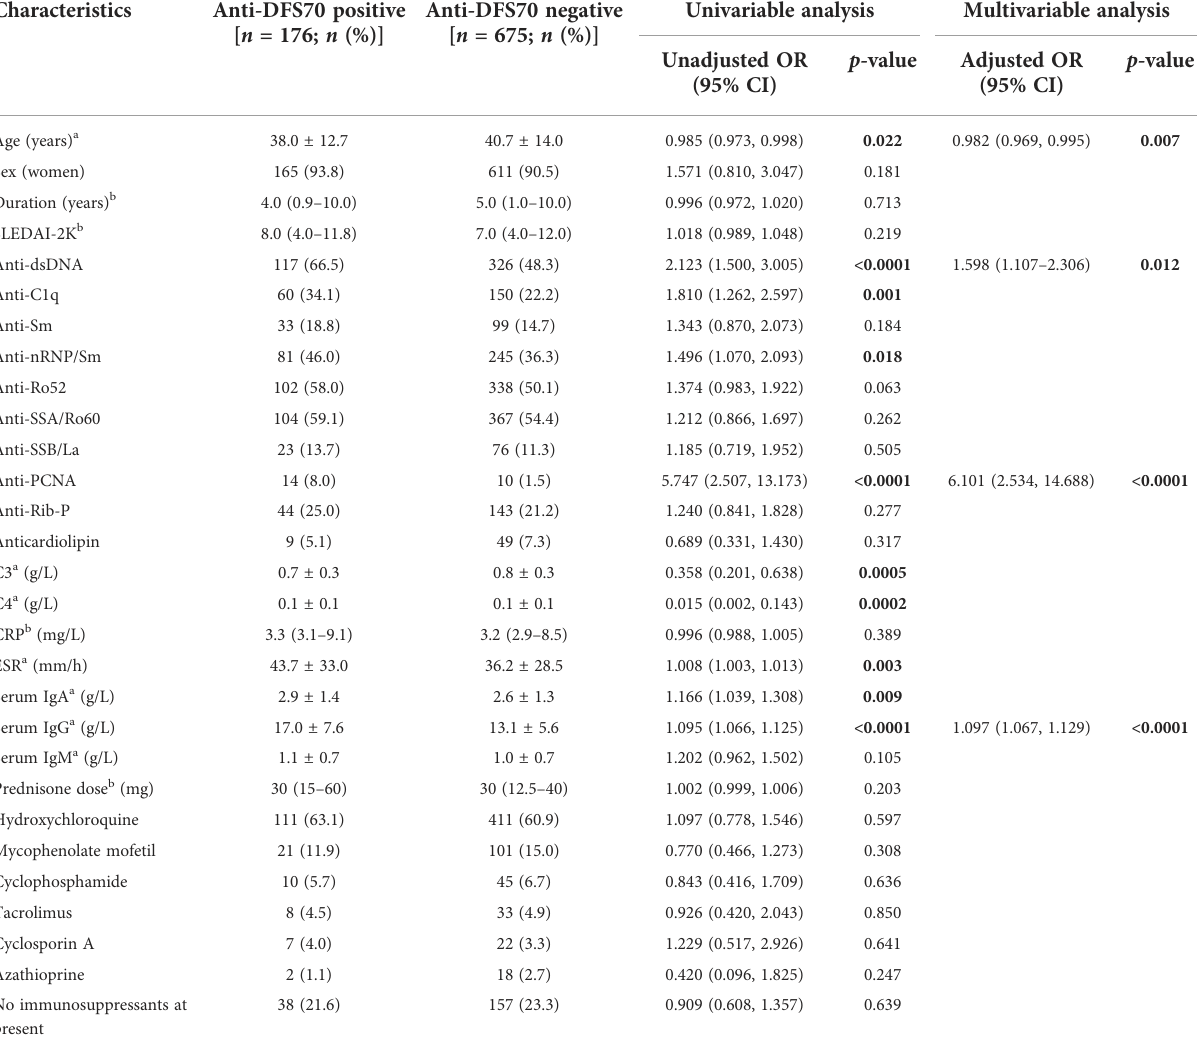
TABLE 2 Comparison of demographic and serological parameters between anti-DFS70-positive and anti-DFS70-negative SLE patients.